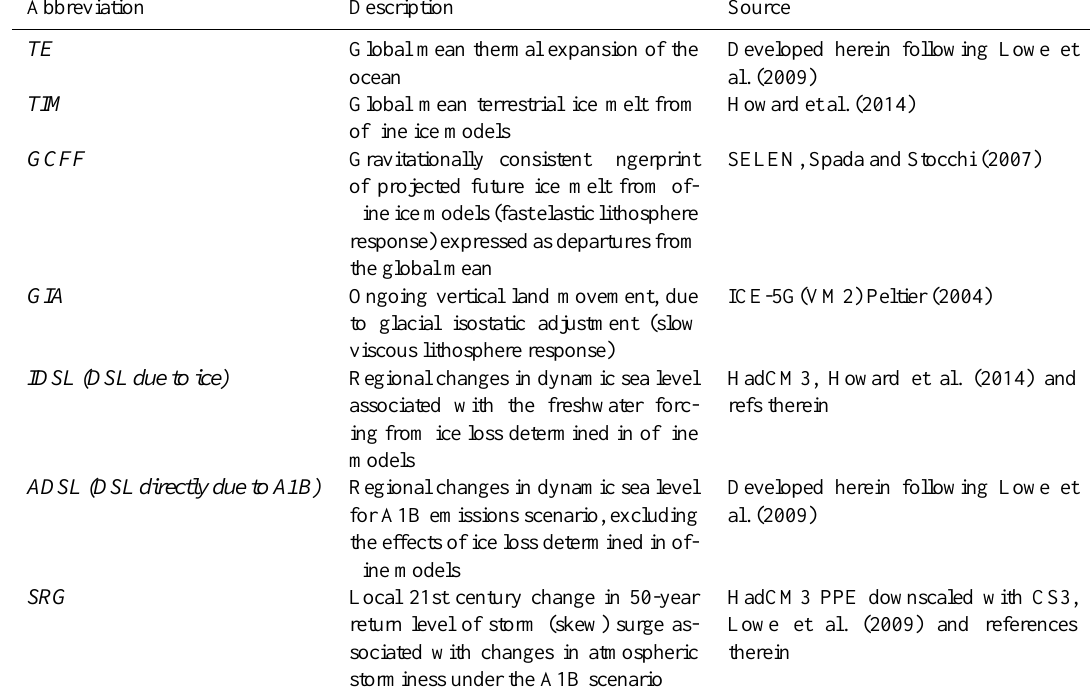
Table 1. Summary of the contributions to 21st century sea-level change included in this